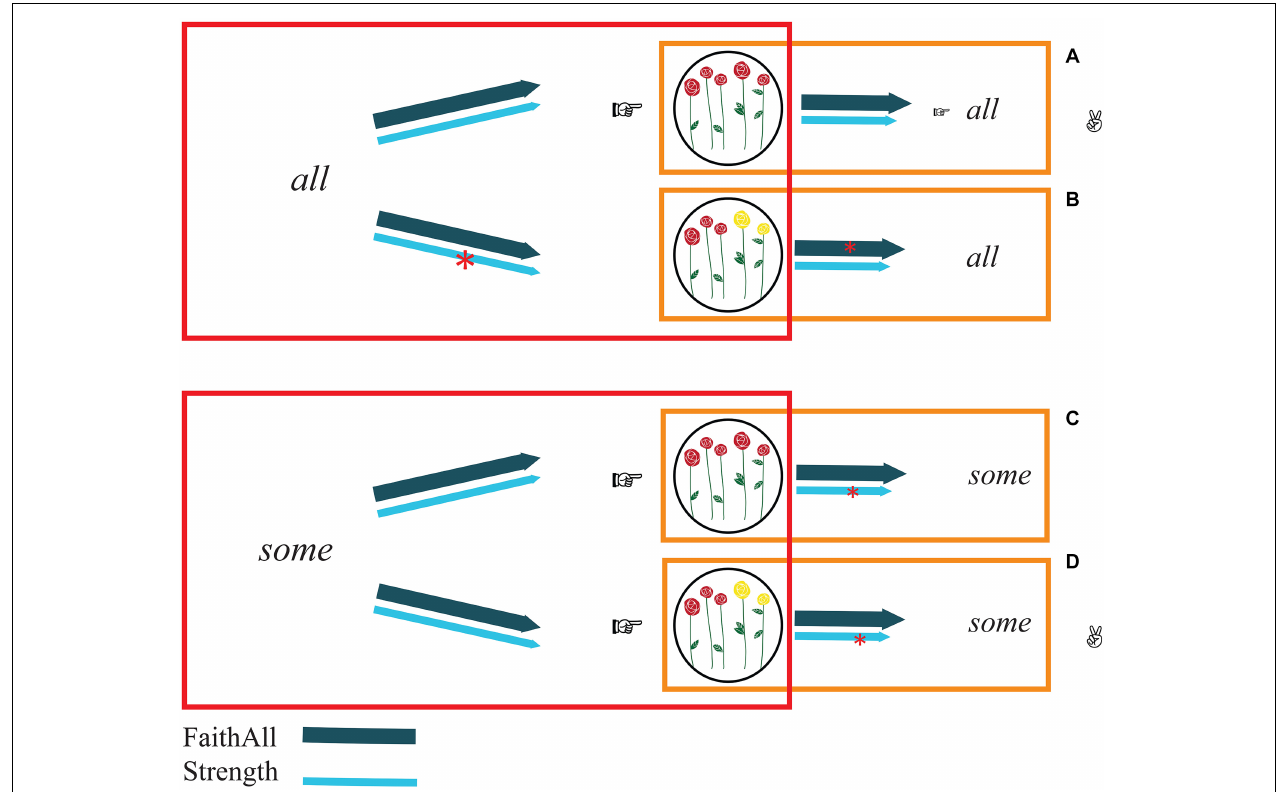
FIGURE 3 | Bidirectional optimization (in comprehension). Panels (A–D) represent the four possible form-meaning associations. The process starts with an evaluation of the optimal meanings given the forms all and some (red boxes) and continues with a second step in which the associations are evaluated according to speakers’ perspective (orange boxes). The first bidirectionally optimal association that can be determined is panel (A) : it does not violate any constraint in comprehension (see red boxes) nor in production (see orange boxes). All the other possible associations violate at least one constraint (see red asterisks).